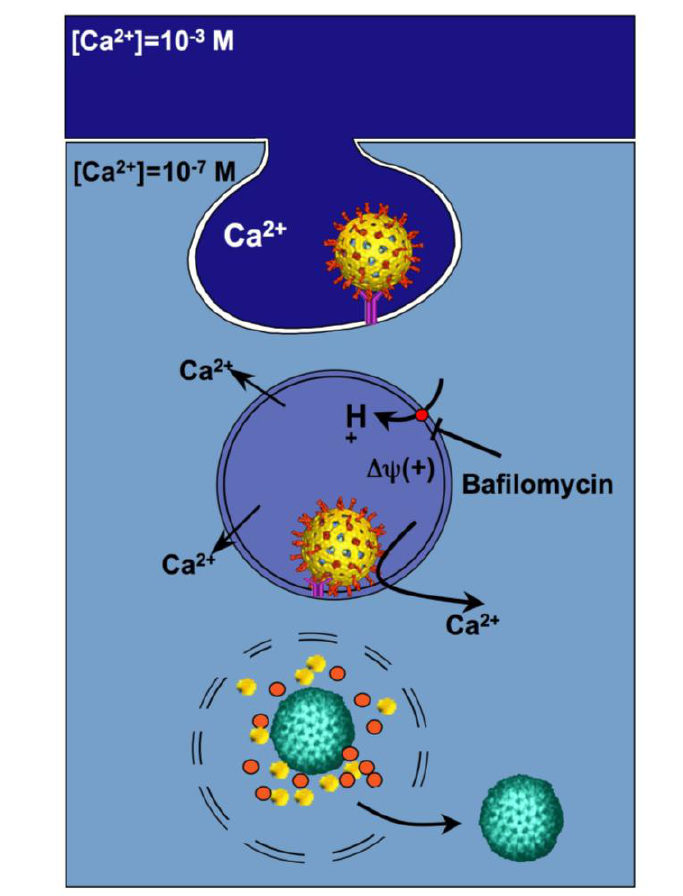
FIGURE 3 . Hypothetical model of rotavirus entry by endocytosis. After rotavirus particles bind to receptors on the cell surface, they are endocytosed into vesicles together with extracellular fluid containing Ca 2+ in the 1 m M range. Once inside the endocytic vesicle, Ca 2+ is transported into the cytoplasm driven by the large concentration gradient (from 1 to 100 n M ). The exposition of VP5 may form a pore and permit Ca 2+ flux into the cytoplasm. The electrical gradient (positive inside) generated by the v-type H + pump provides an additional force for Ca 2+ extrusion out of the endosome. Once Ca 2+ has dropped to a critical concentration, the virus uncoats and the external solubilized proteins, VP5* and perhaps VP7, permeabilize and lyse the endosomal membrane. In this way, the DLP gains access to the cytoplasm and replication is